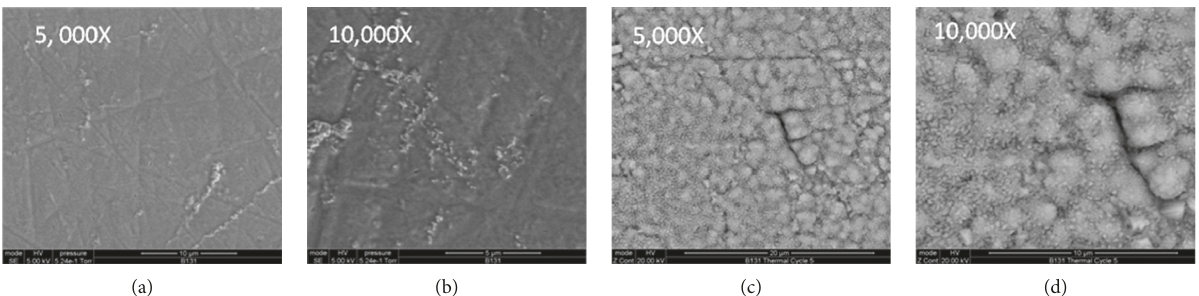
Figure 10: Sample YSZ-B131 before and after thermal cycling. (a) Before thermal cycling, shown at 5,000X. (b) Before thermal cycling, shown at 10,000X. (c) After thermal cycling, shown at 5,000X. (d) After thermal cycling, shown at 10,000X. The nonthermally cycled sample EDX shows only iron (Fe), Y, Zr, and oxygen (O).